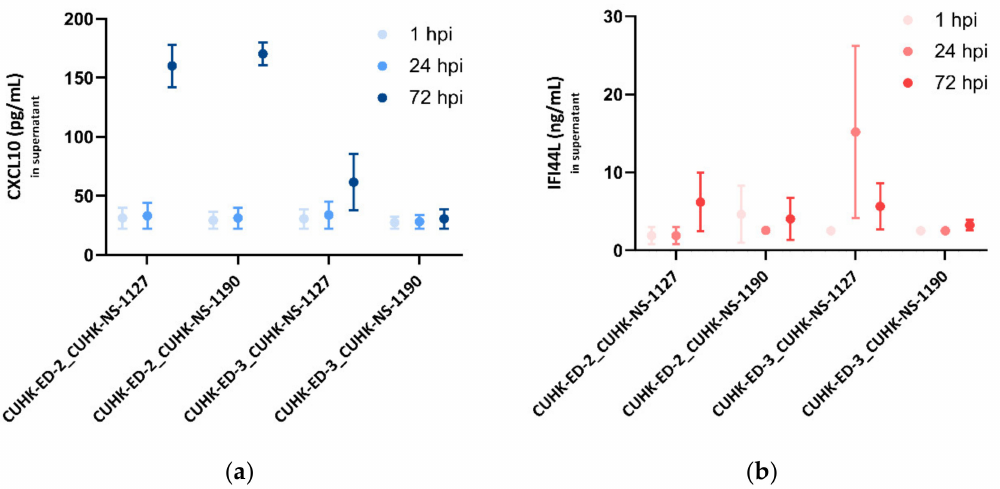
Figure 6. Secreted ( a ) CXCL10 (pg/mL) and ( b ) IFI44L (ng/mL) levels in enteroid lines at 1, 24 and 72 hpi as measured by ELISA: three independent experiments as technical replicates were performed using the supernatants infected with CUHK-NS-1127 and CUHK-NS-1190. Error bars denote standard error of the